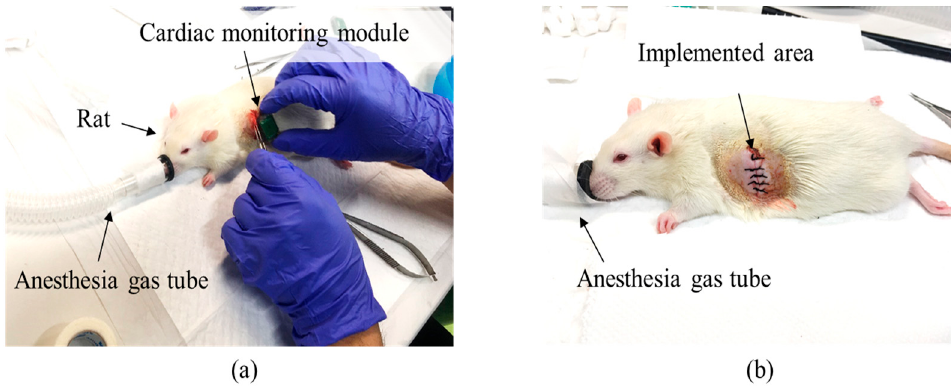
Figure 15. Photographs of the animal experiment. The rat was kept under anesthesia during the experiment. ( a ) Captured image of the cardiac monitoring system implant surgery. ( b ) Image of the area of the cardiac monitoring system.